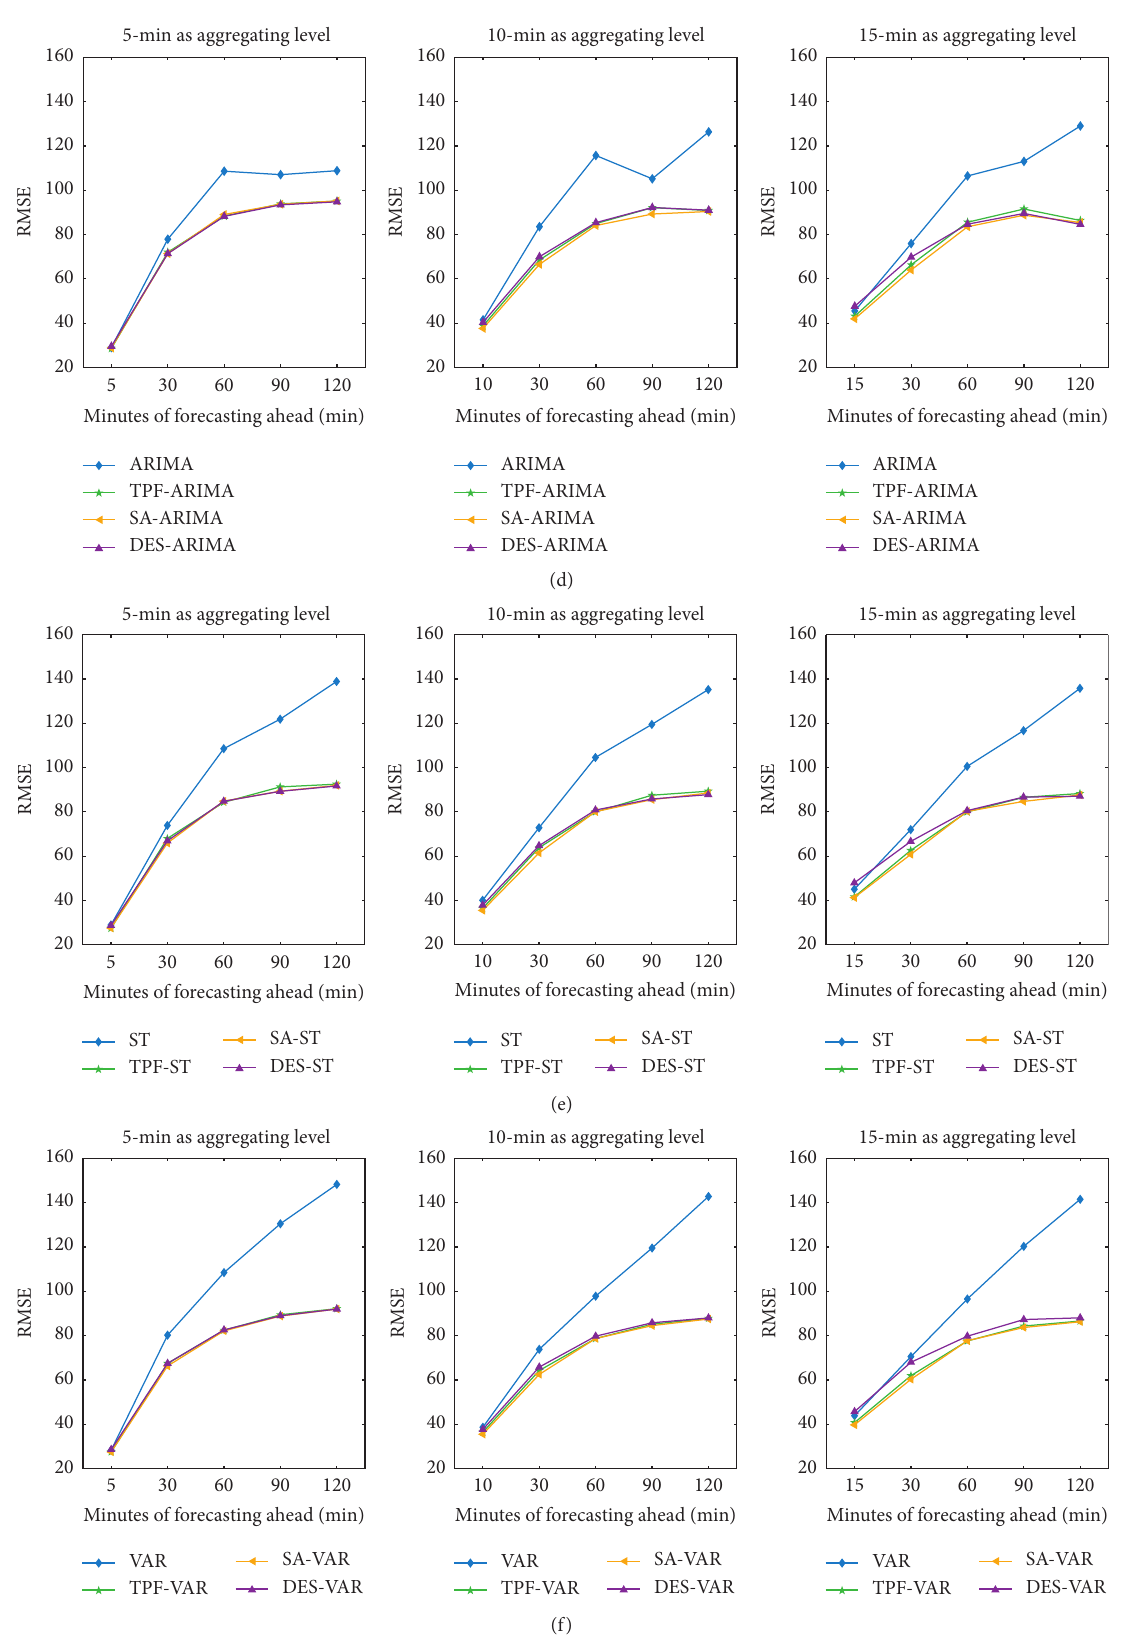
Figure 6: RMSE values of six models for different minutes ahead predictions. (a) RMSE values of SVM models for different minutes ahead predictions. (b) RMSE values of BPNN models for different minutes ahead predictions. (c) RMSE values of MLR models for different minutes ahead predictions. (d) RMSE values of ARIMA models for different minutes ahead predictions. (e) RMSE values of STmodels for different minutes ahead predictions. (f) RMSE values of VAR models for different minutes ahead